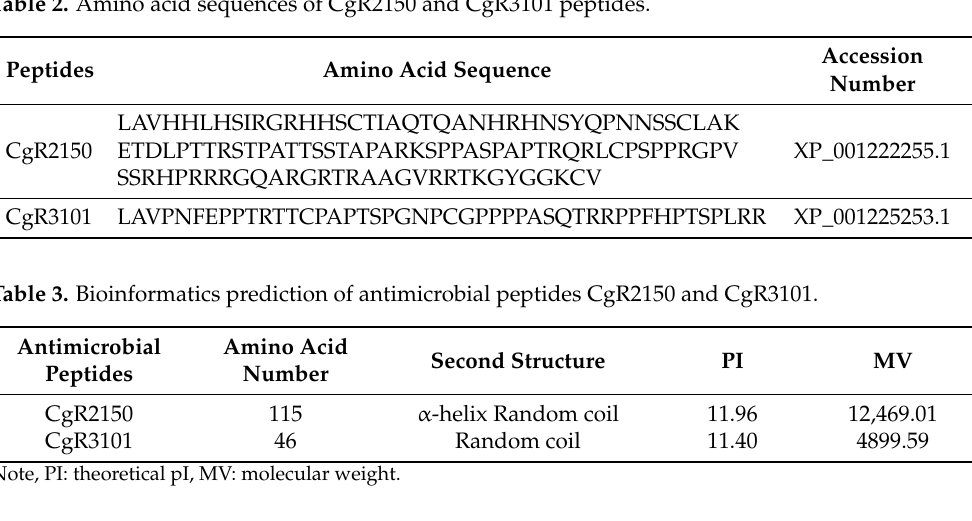
Table 2. Amino acid sequences of CgR2150 and CgR3101 peptides.